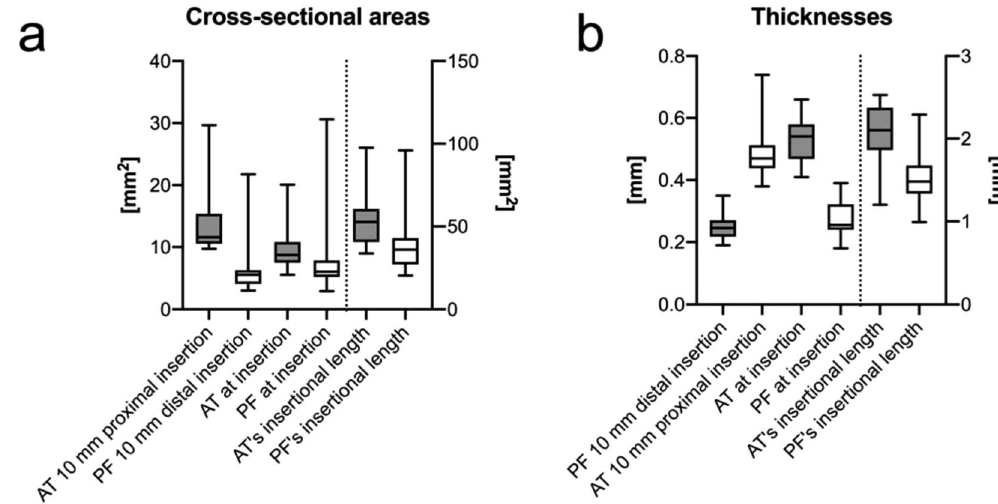
Figure 3. The cross-sectional areas ( a ) and thicknesses ( b ) of the samples are graphically depicted. AT Achilles tendon; PF plantar